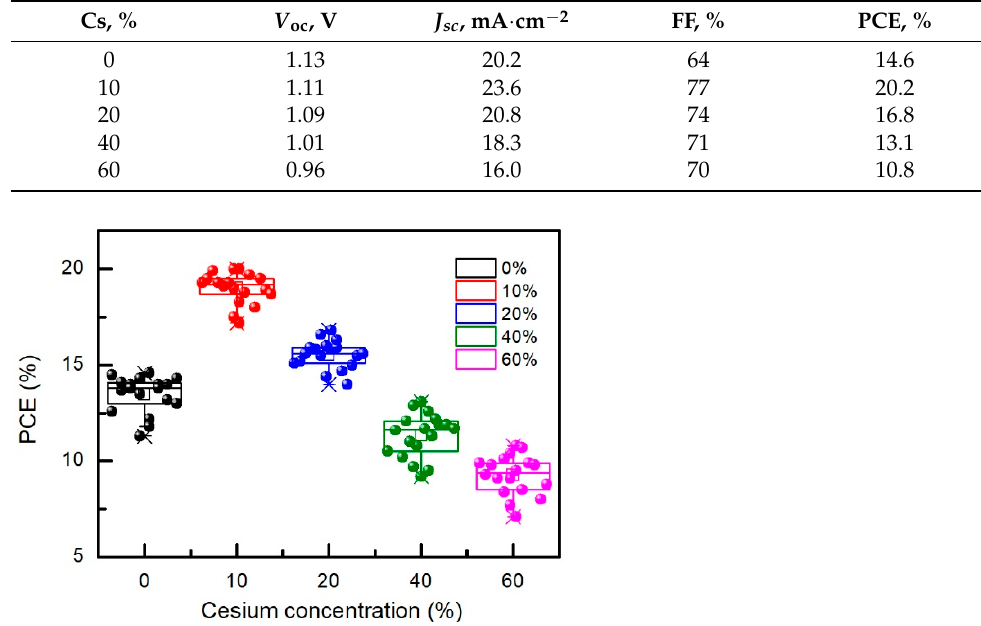
Figure 11. Current voltage characteristics of perovskite solar cells with different cesium concentration. Light intensity is 100 mW/cm 2 of AM 1.5 spectral lamp. Table 3. Photovoltaic parameters of the perovskite solar cells with different cesium concentration.